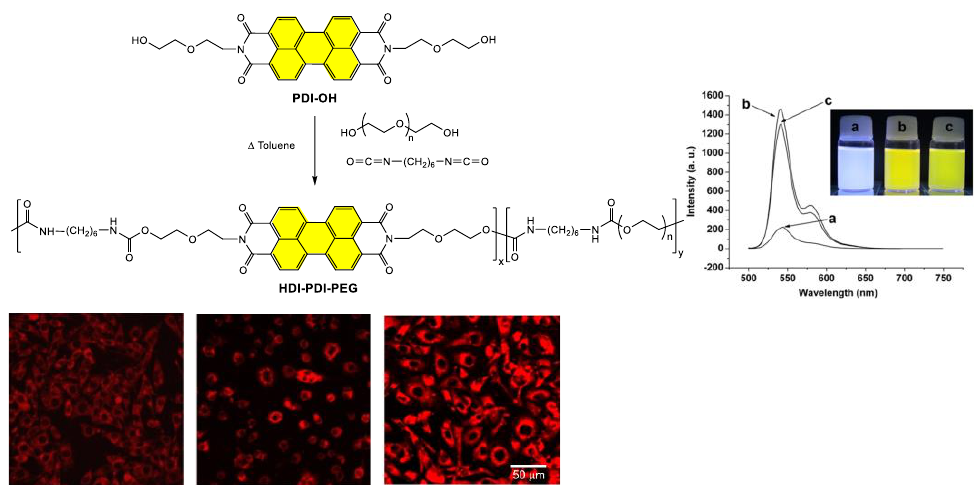
Figure 6. Synthesis of HDI-PDI-PEG copolymer; fluorescence spectra of ( a ) HDI-PDI-PEG 600 , ( b ) HDI-PDI-PEG 1500 and ( c ) HDI-PDI-PEG 2000 at a concentration of 0.6 mg/mL in water; confocal laser scanning microscopy images of L929 cells ( left ), macrophages ( middle ) and skov-3 cells ( right ) in a medium containing 0.125 mg/mL HDI-PDI-PEG 1500 . Reprinted with permission from reference [103]. Copyright 2016 Elsevier.